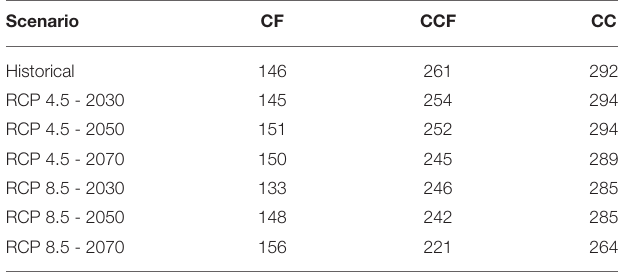
TABLE 2 | Average dryland winter wheat transpiration (mm) in each agroecological class of the Inland Pacific Northwest for the historical and future scenarios under 2 representative concentration pathways